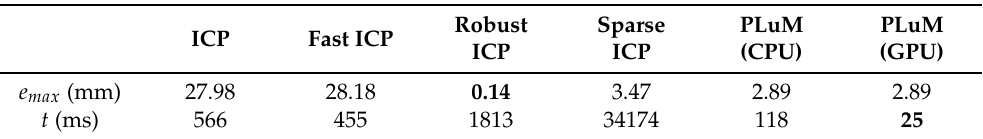
Figure 7. Two candidate problems with the same ground truth and point cloud consisting of 202 measurements. The different seeds, or initial guesses, are displayed in green. ( a ) Provides significant overlap between the point cloud and the initial position, whereas ( b ) is a harder problem having an initial position with no overlap. Table 2. The maximum vertex error and execution time for each method in the problem depicted in Figure 7a. The best results are displayed in